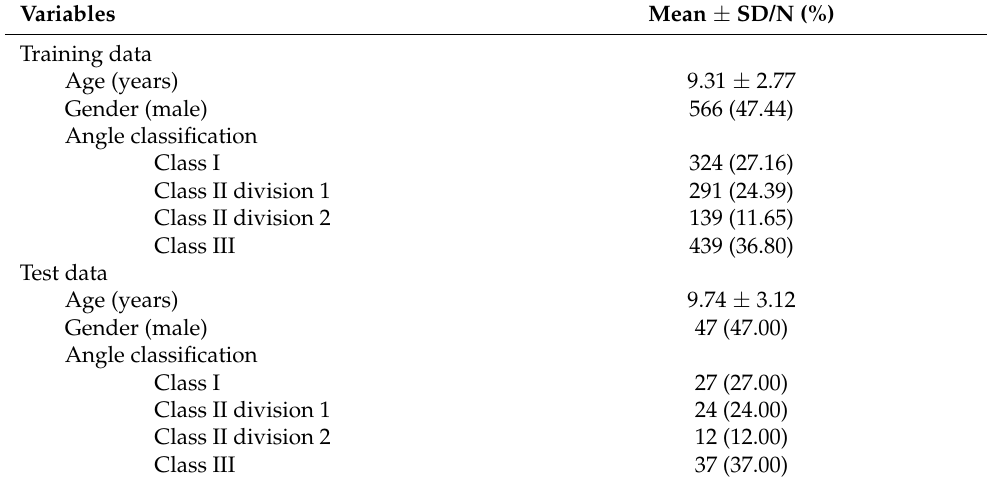
Table 1. Descriptive summary of study data.